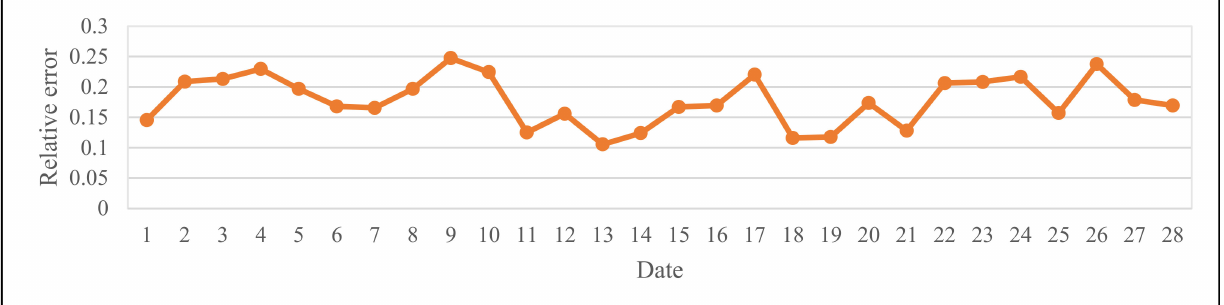
Figure 3. Relative error of cash flow forecast of G company in January 2019.